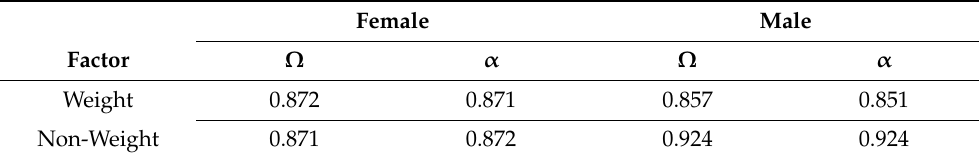
Table 9. Coefficients omega and alpha for the obtained